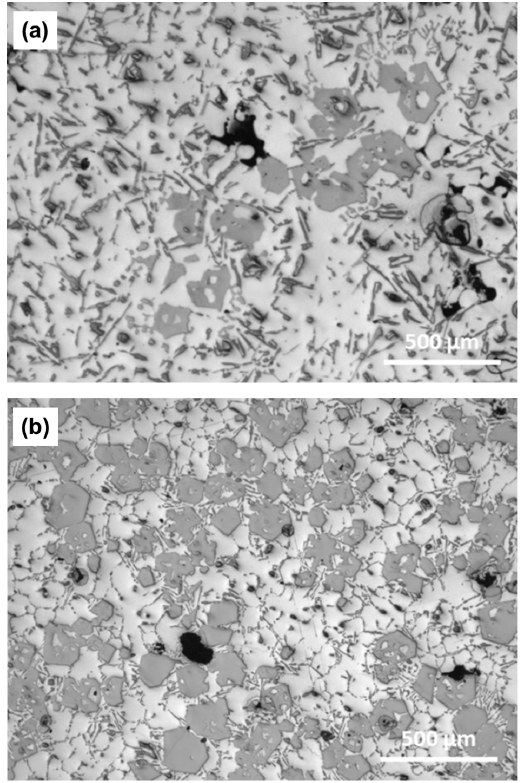
Figure 7. Optical micrographs showing the Fe-containing intermetallics at the bottom of a solidified A380-1Mn-1Fe alloy ( a ) without and ( b ) with HSMC.